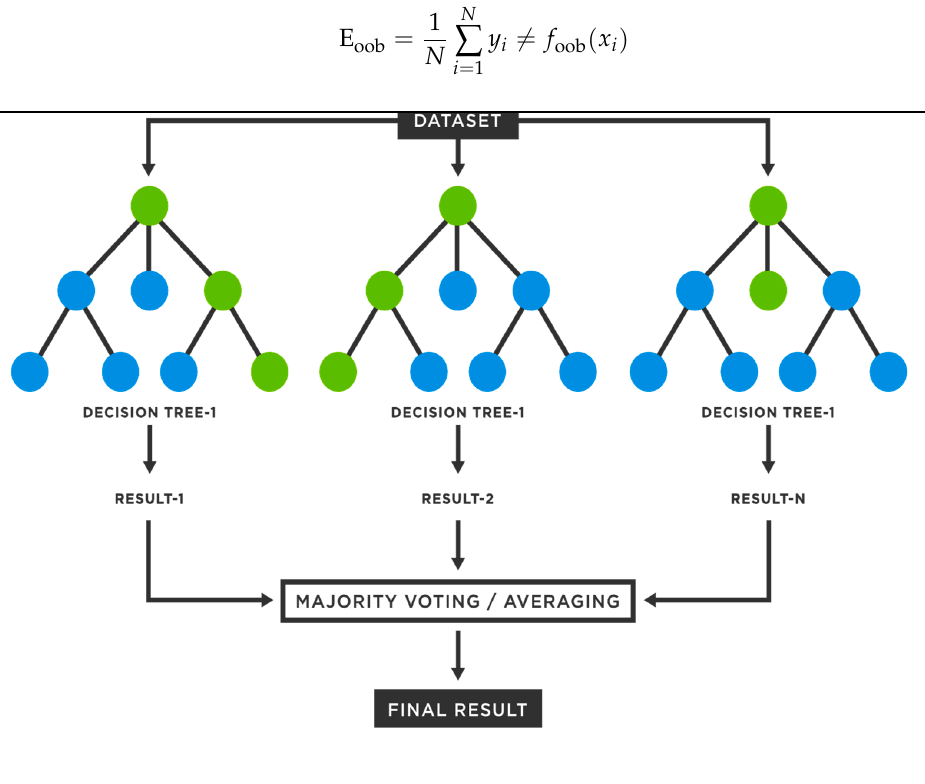
Figure 5. Illustration of random forest trees.